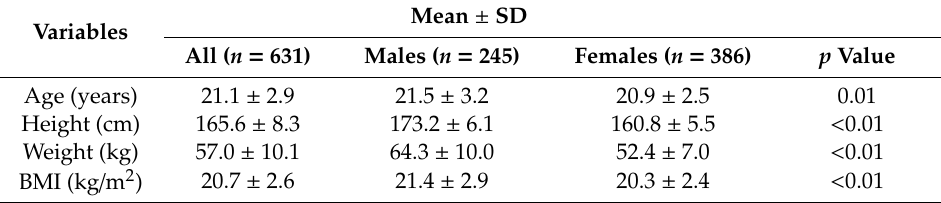
Table 1. Participant characteristics for cross-sectional study and stratified by